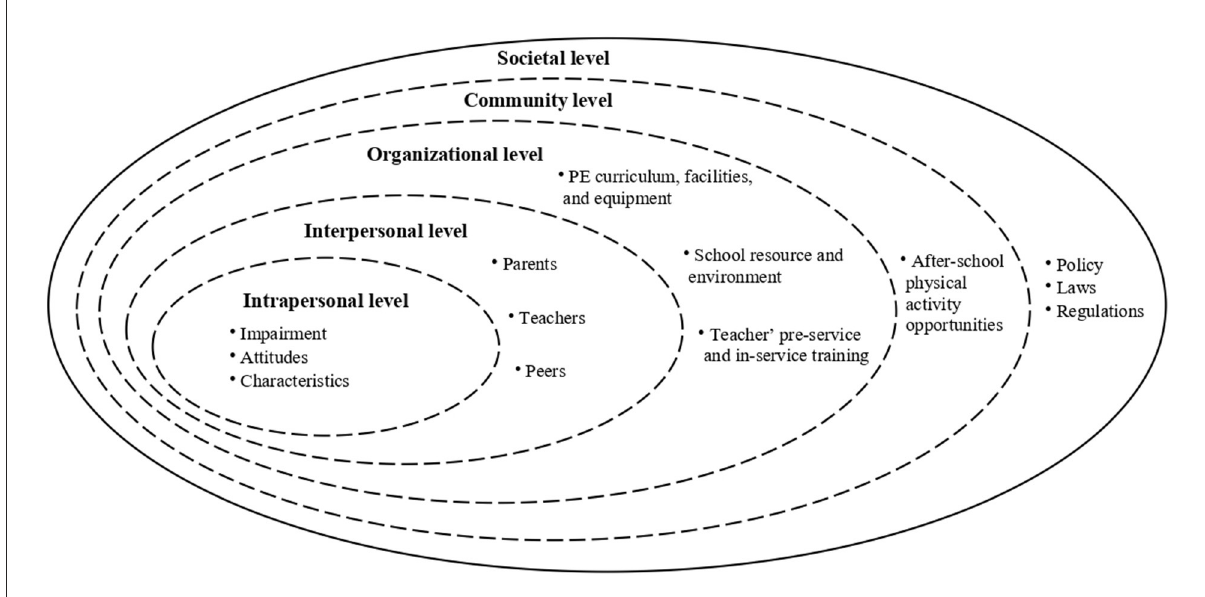
FIGURE1 Socio-ecological model. Adapted from McLeroy et al.